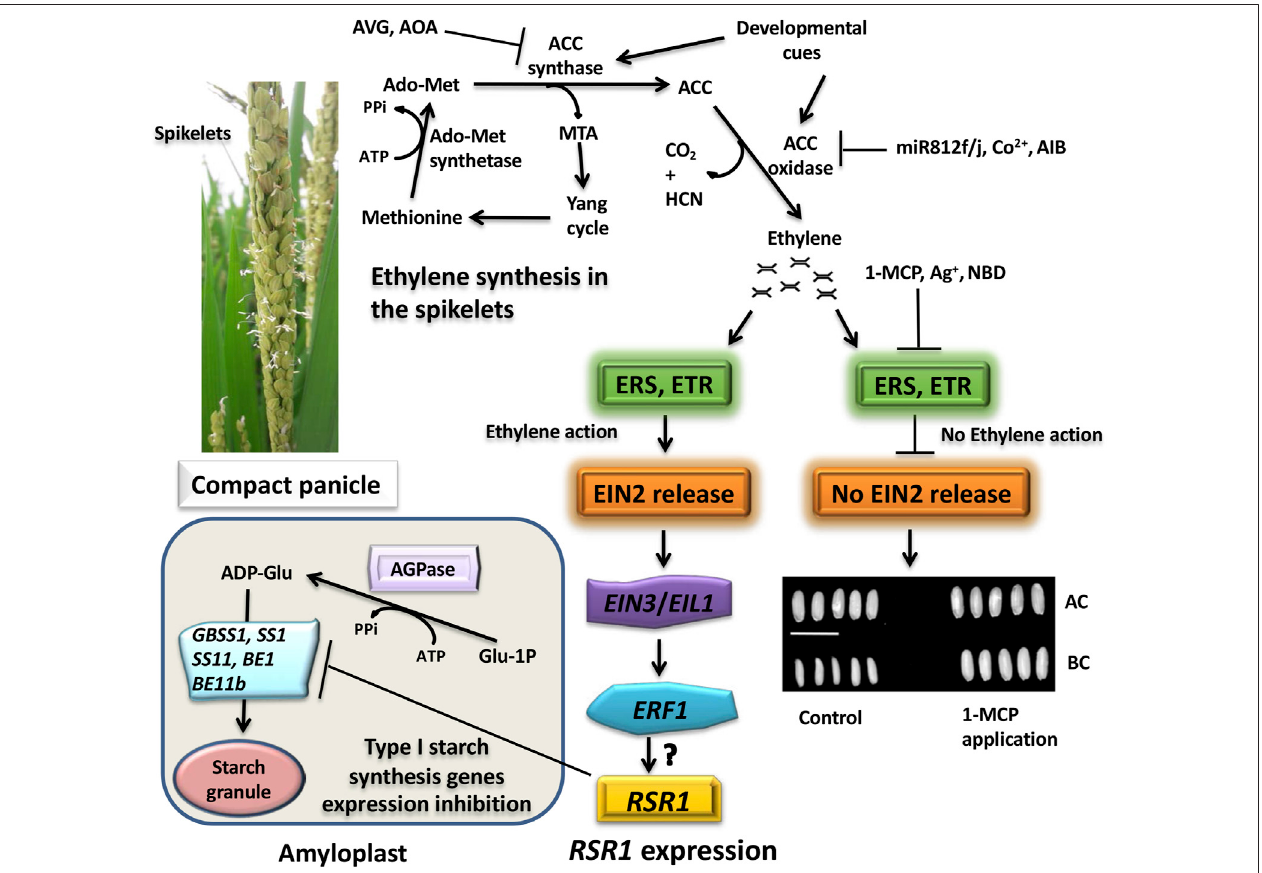
FIGURE 9 | Pictorial presentation of ethylene biosynthesis and ethylene action. Ethylene is synthesized from methionine by the action of ACC synthase that forms ACC (1-aminocyclopropane-1-carbooxylic acid), which is catalyzed by ACC oxidase (ACO) to yield ethylene and HCN as the byproduct. Methionine is regenerated via the Yang cycle. Ethylene action leads to the synthesis of Rice Starch Regulator1 (RSR1), which reportedly inhibits the expression of the type I starch-biosynthesizing enzymes, leading to inhibition of starch biosynthesis and poor grain fi lling. Inhibition of ethylene synthesis by AVG (2-aminoethoxyvinyl glycine), AOA (2- aminoooxyacetic acid), AIB (aminoisobutyric acid), Co 2+ , and the miRNAs miR812f/j and blocking of the ethylene action by the use of ethylene receptor blockers like 1- MCP (1-methylcyclopropene), Ag + , and NBD (2,5-norbornadiene) lead to no ethylene action resulting in proper fi lling of the grain. MTA, methylthioadenine; Ado-Met, adinosyl-methionine; ERS, ETR, ethylene receptors; AC, apical caryopses; BC, basal